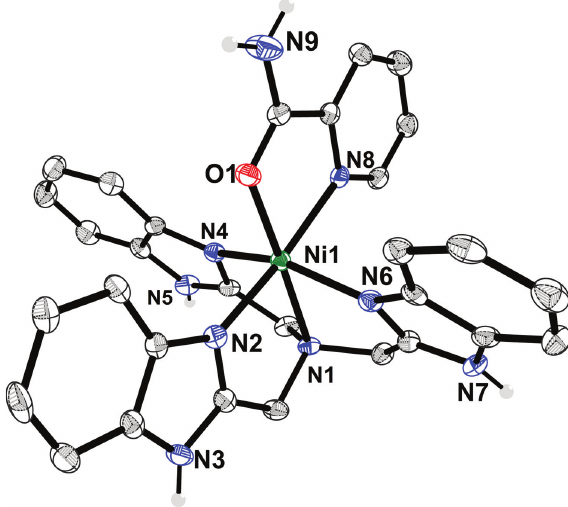
Table 1: Data collection and handling.